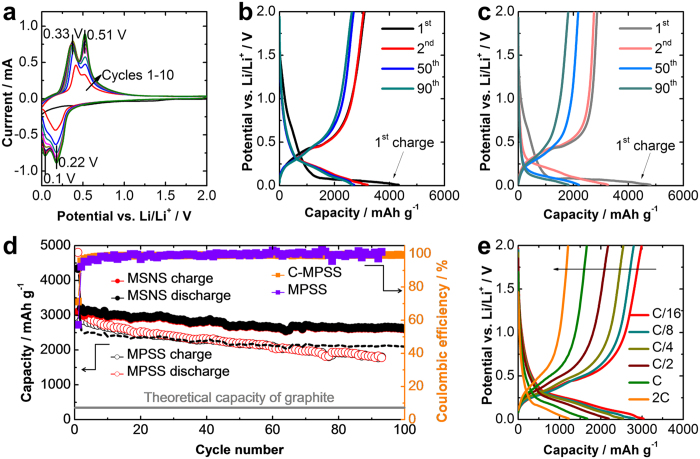
(a) Cyclic voltammetry characteristic of the MSNS based LIB anodes. Scan rate: 0.2 mV sec−1. (b,c) 1st, 2nd, 50th, 90th galvanostatic charge-discharge profiles of MSNS and MPSS respectively. (d) Cycling performance and coulombic efficiency of the MSNS and MPSS electrodes at a current density of C/2021. (e) Galvanostatic charge-discharge profiles of MSNS electrodes under different rates of charge and discharge.